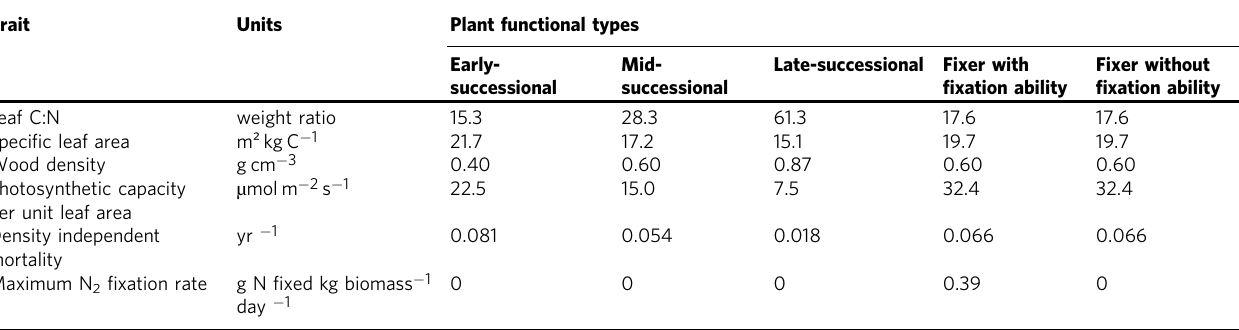
Table 1 Ecophysiological and life-history traits of the plant functional types (PFTs) used in model simulations.